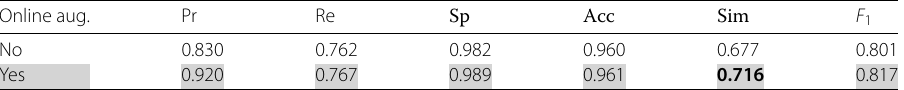
and S 2000 with lr = 0.002 and λ = 0.0001 aug